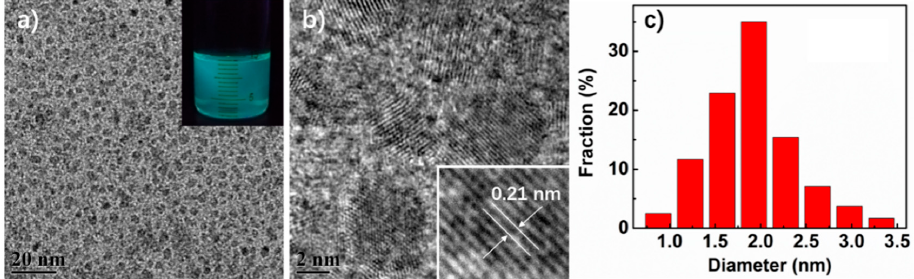
Figure 1. ( a ) TEM image (the inset is the CDs suspension under 365 nm UV); ( b ) HR-TEM image; ( c ) ( c ) particle size distribution of CDs calculated from TEM image.